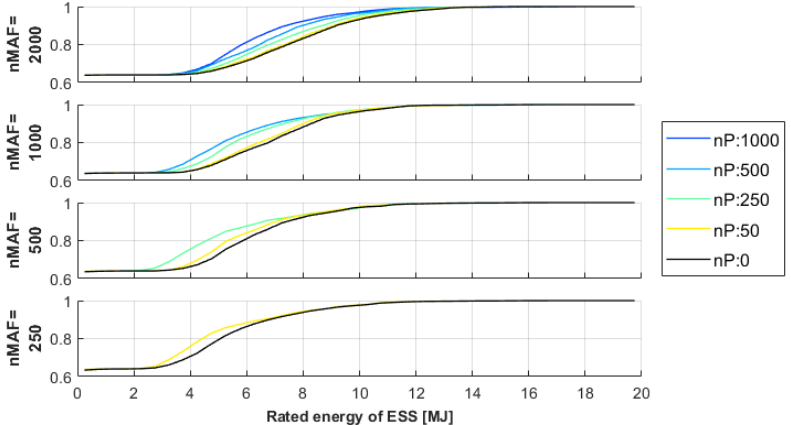
Figure 12. Cumulative distribution function of energy storage required for di ff erent window lengths ( nMAF ) and future samples ( nP